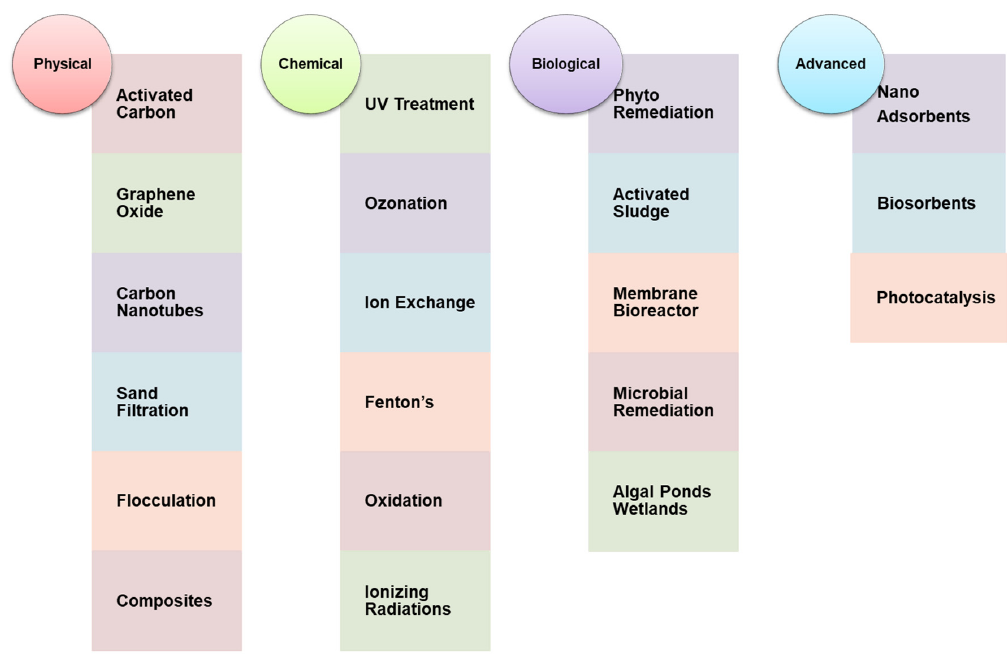
Figure 2. Conventional treatment technologies. Table 2. Comparison between conventional and advanced nanotechnological